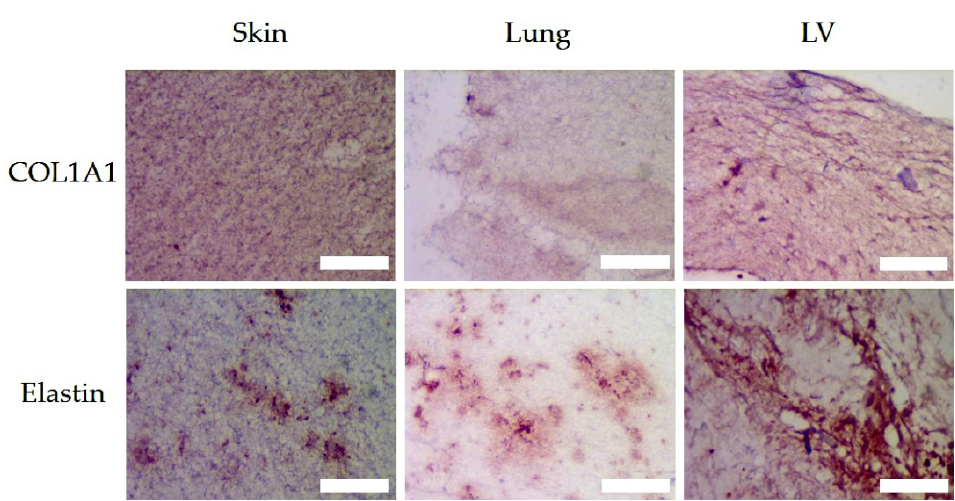
Figure 7. Immunohistochemistry (red) of COL1A1 and Elastin of skin, lung and LV ECM hydrogels. Scale bars represent 50 µm.